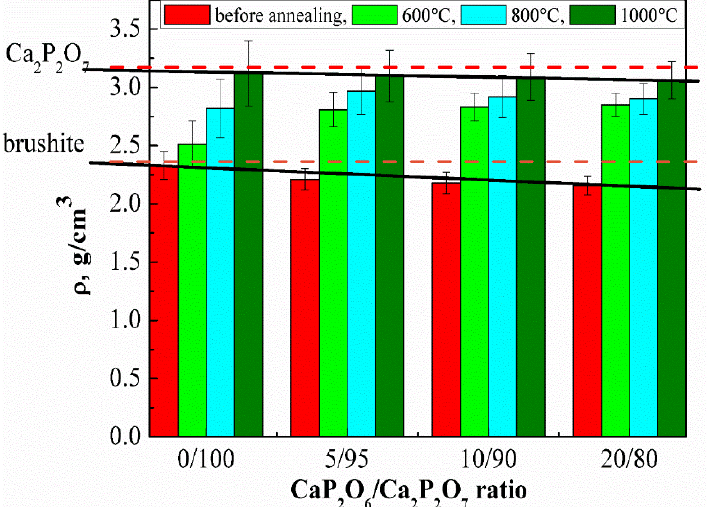
Figure 12. The true density of the ceramic materials before and after annealing in the temperature range of 600 – 1000 °C. range of 600–1000 ◦